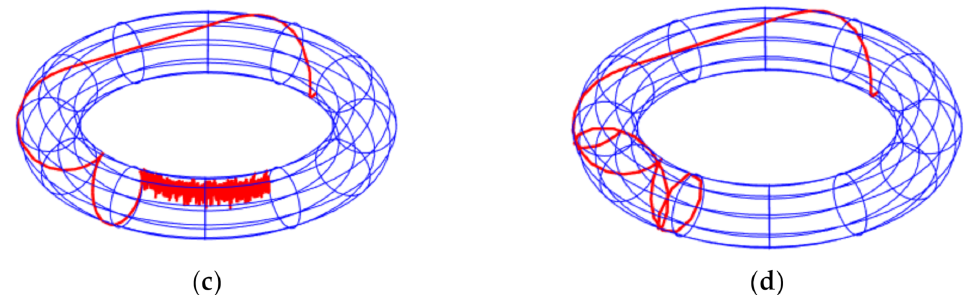
Figure 2. Coordinate system of different parts and compare between two trajectories with different variables. ( a ) Torus coordinate system; ( b ) Cylinder coordinate system; ( c ) Trajectory with u as an independent variable; ( d ) Trajectory with s as an independent variable.